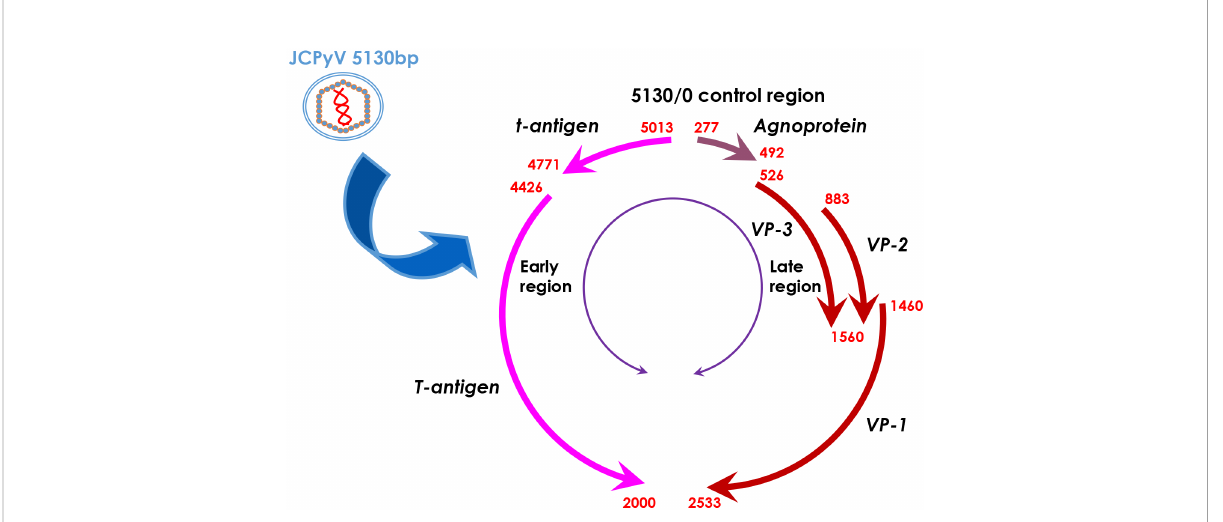
FIGURE 1 The genomic DNA structure of JCPyV. JCPyV has icosahedral capsids and small, circular, double-stranded genomic DNA of 5130 base pairs. It is composed of early and late coding regions, which are transcribed in opposite directions initiated by a transcriptional control region. The early region encodes both small and large T antigens by alternative splicing. The late region encodes the capsid structural proteins (VP1, VP2 and VP3) by alternative splicing and a small regulatory protein,